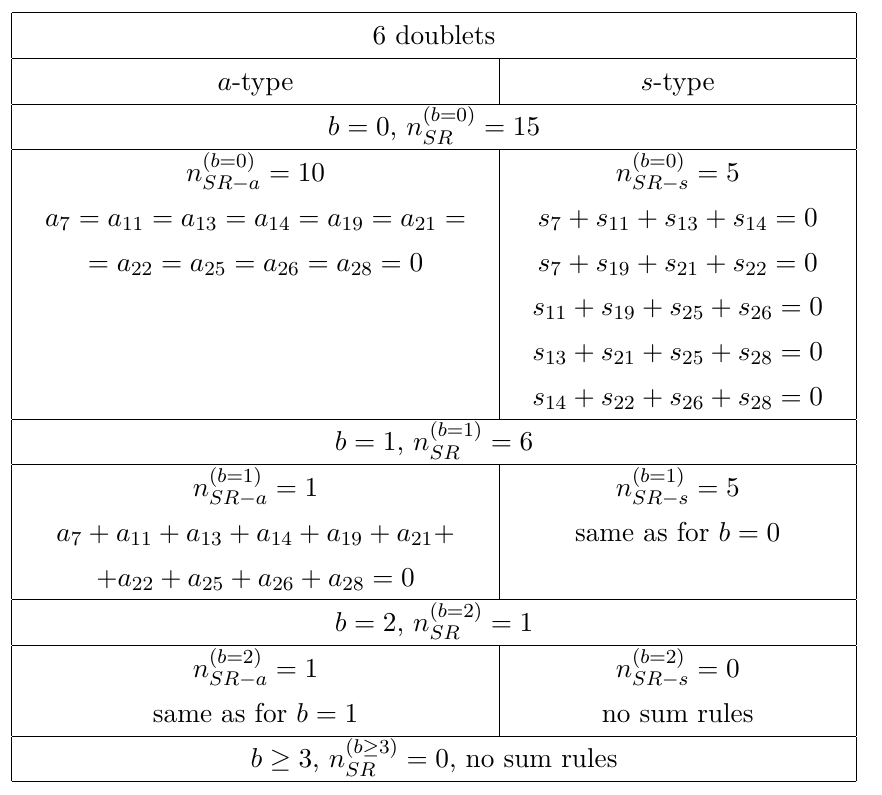
, n ( b ) and SR SR − a